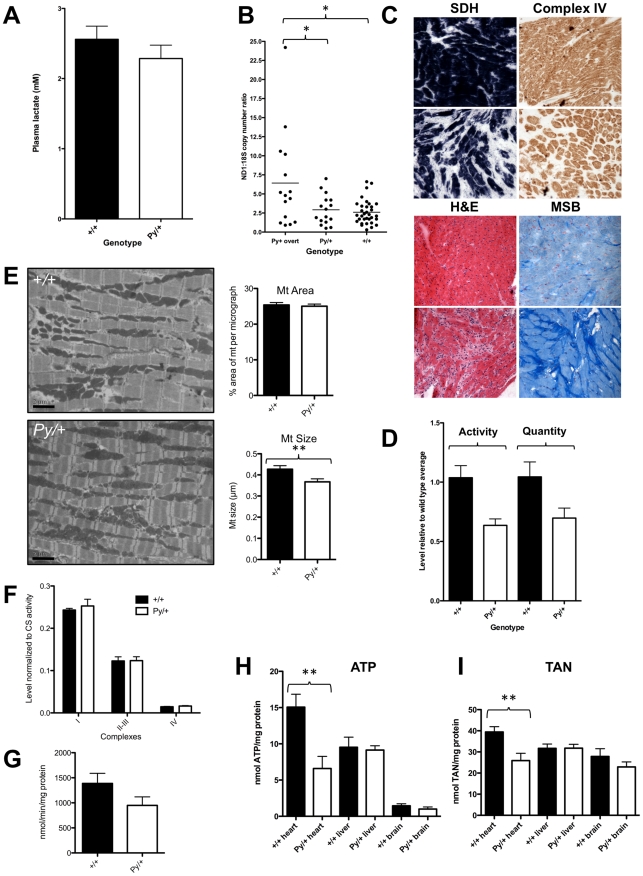
Cardiomyocyte energy metabolism is altered in Python mice.(A) Plasma lactate levels (mean ± SEM) in adult Python (n = 29) and wild type (n = 33) mice aged between 5 and 9 weeks and in mice. Sexes have been pooled. (B) The relative mitochondrial:nuclear DNA levels in heart samples from Python and control mice as assessed using Q-PCR. ‘Py/+ overt’ refers to heart samples taken from Python mice at the time of overt symptoms of heart failure. All other mice were aged between 5 and 7 weeks at time of sampling. *P<0.05, 1-way Anova with Bonferroni's Multiple Comparison Post-Test. (C) Typical example of enzyme histochemical staining for succinate dehydrogenase (SDH) and Complex IV from hearts of Python males suffering from overt CHF (aged 93 days) and an age-matched littermate control. Typical sections stained with Haematoxylin and Eosin (H&E) and Martius/Scarlet Blue (MSB) to stain connective tissue are shown for comparison. Note the scarring and loss of myocytes in Python hearts. (D) Comparison of Complex IV activity and quantity (mean ± SEM) measured in extracts from hearts of Python mice showing overt signs of CHF and wild type controls aged 91–103 days (n = 7 Python, n = 7 controls). (E) Representative transmission electron micrographs of Python and control hearts from mice aged 9–10 weeks. Scale bar = 2 µm. The graphs on the right summarizes the morphometric measurements (mean ± SEM) of mitochondrial area (reflecting volume per cell) and mitochondrial size in Python (4 mice; n = 75 micrographs) and wild type (4 mice; n = 55 micrographs) heart EM images. **P<0.01. (F) Mitochondrial respiratory complex enzyme activities (mean ± SEM measured in extracts of heart tissue from Python (n = 8) and control mice (n = 8) aged 10 weeks and normalized to level of citrate synthase activity. All activities expressed as nmol/min/mg total protein except complex IV which is expressed as k/min/mg. Complex I: NADH: Ubiquinone reductase, Complex II–III: Succinate: Cytochrome c reductase, Complex IV: Cytochrome c oxidase. (G) Overall citrate synthase activity (mean ± SEM nmol/min/mg total protein) in heart extracts from H (n = 8 Python and n = 8 wild type, Student's t test P = 0.12). (H) ATP level (mean ± SEM) after normalization to total protein level in extracts of tissue from Python and control mice at age 10 weeks. Student's t test P values are: heart +/+ (n = 7) vs. Py/+ (n = 6): P = 0.006; liver +/+ (n = 6) vs. Py/+ (n = 6): P = 0.80; brain +/+ (n = 6) vs. Py/+ (n = 5): P = 0.29. (I) Total adenine nucleotide pool (TAN) in extracts of tissue from Python and control mice at age 10 weeks. Values shown are mean ± SEM nmol ATP + ADP + AMP normalized to mg protein. Student's t test P values are: heart +/+ (n = 7) vs. Py/+ (n = 6): P = 0.008; liver +/+ (n = 6) vs. Py/+ (n = 6): P = 0.97; brain +/+ (n = 6) vs. Py/+ (n = 5): P = 0.31.